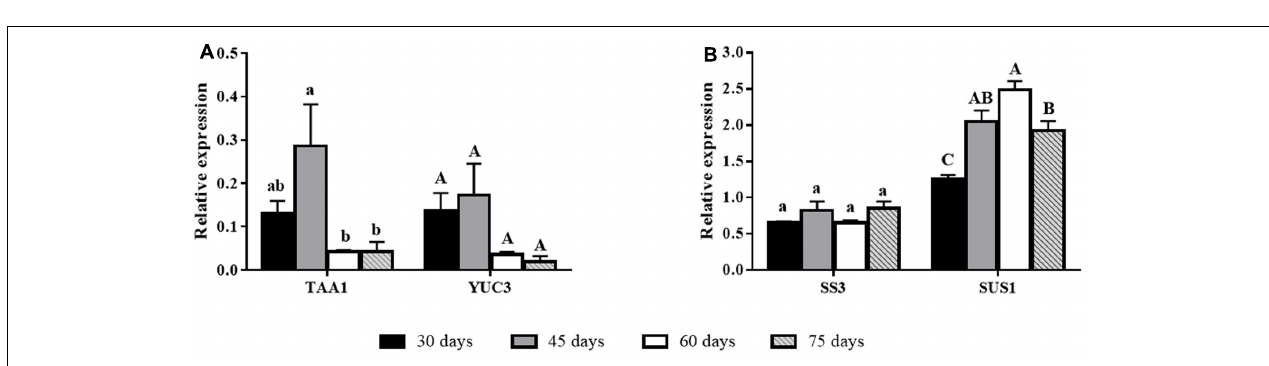
FIGURE 2 | Gene expression of auxin action mechanism-related genes in E. globulus tip cuttings as a function of donor plant age (rooting competence diminishes between 45 and 75 days). Black bars – 45 days; light gray bars – 75 days, dark gray bars – 105 days. (A) Ethylene and cytokinin auxin crosstalk-related genes ERF and ARR1 . (B) Inhibitors of auxin responsive genes TPL and IAA12 . (C) Auxin receptors ABP1 and TIR1 . (D) Auxin transporter genes AUX1 and PIN1 . Expression levels genes were evaluated using qPCR and normalized against H2B and TUA as endogenous control genes. Values represent average of biological triplicates analyzed in technical quadruplicates. Bars sharing the same letters are not different according to Tukey test with P ≤ 0.05. Lines on top of bars represent standard errors.